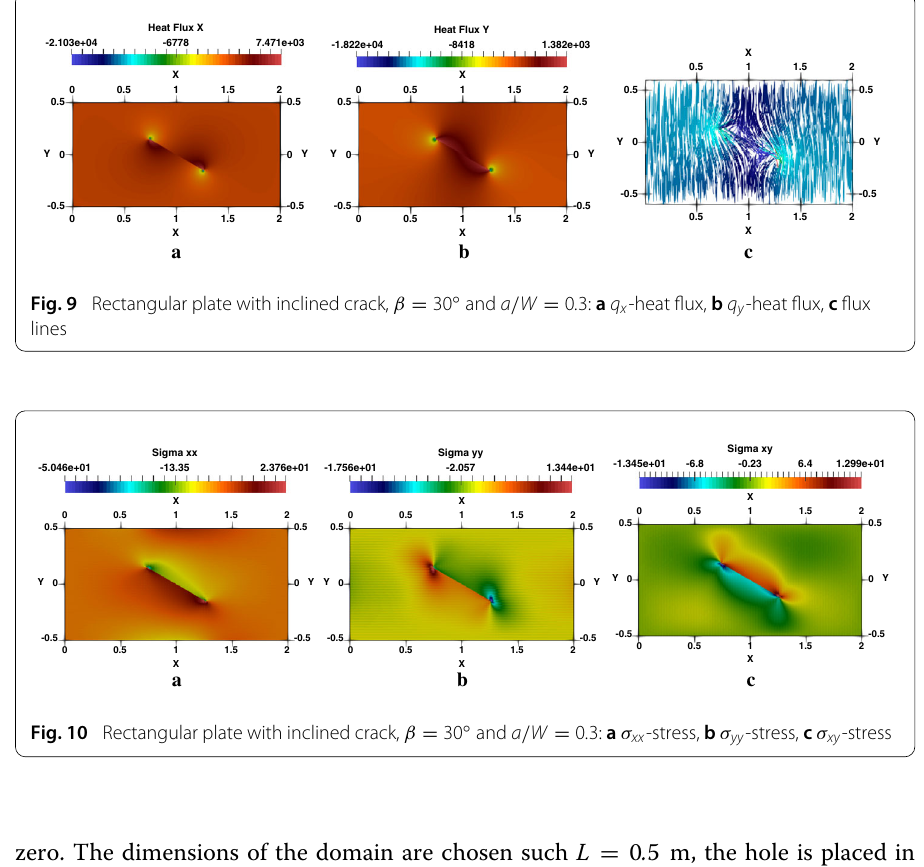
zero. The dimensions of the domain are chosen such L = 0 . 5 m, the hole is placed in the center of the plate defined by the radius R Fig. 11a. The two cracks are defined at the two ends, right and left, of the hole are centered (right and left cracks), with a length l . Half-length of the apparent crack is defined by a = l + R . The bottom left corner is clamped and displacements along e y -axis is fixed. The heat flux is zero at the right and left edges, an imposed temperature of ± (cid:20) 0 are defined at the top and bottom sides, such (cid:20) = 10 ◦ 0